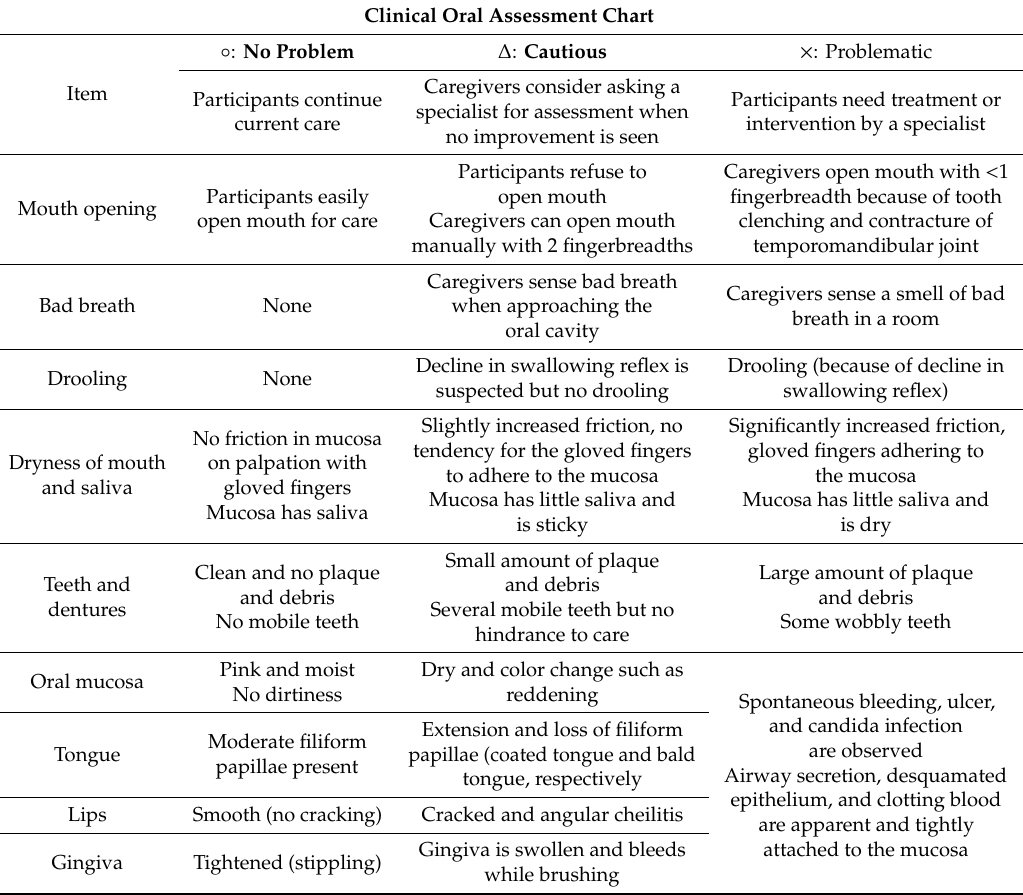
Table 1. Clinical Oral Assessment Chart. Clinical Oral Assessment